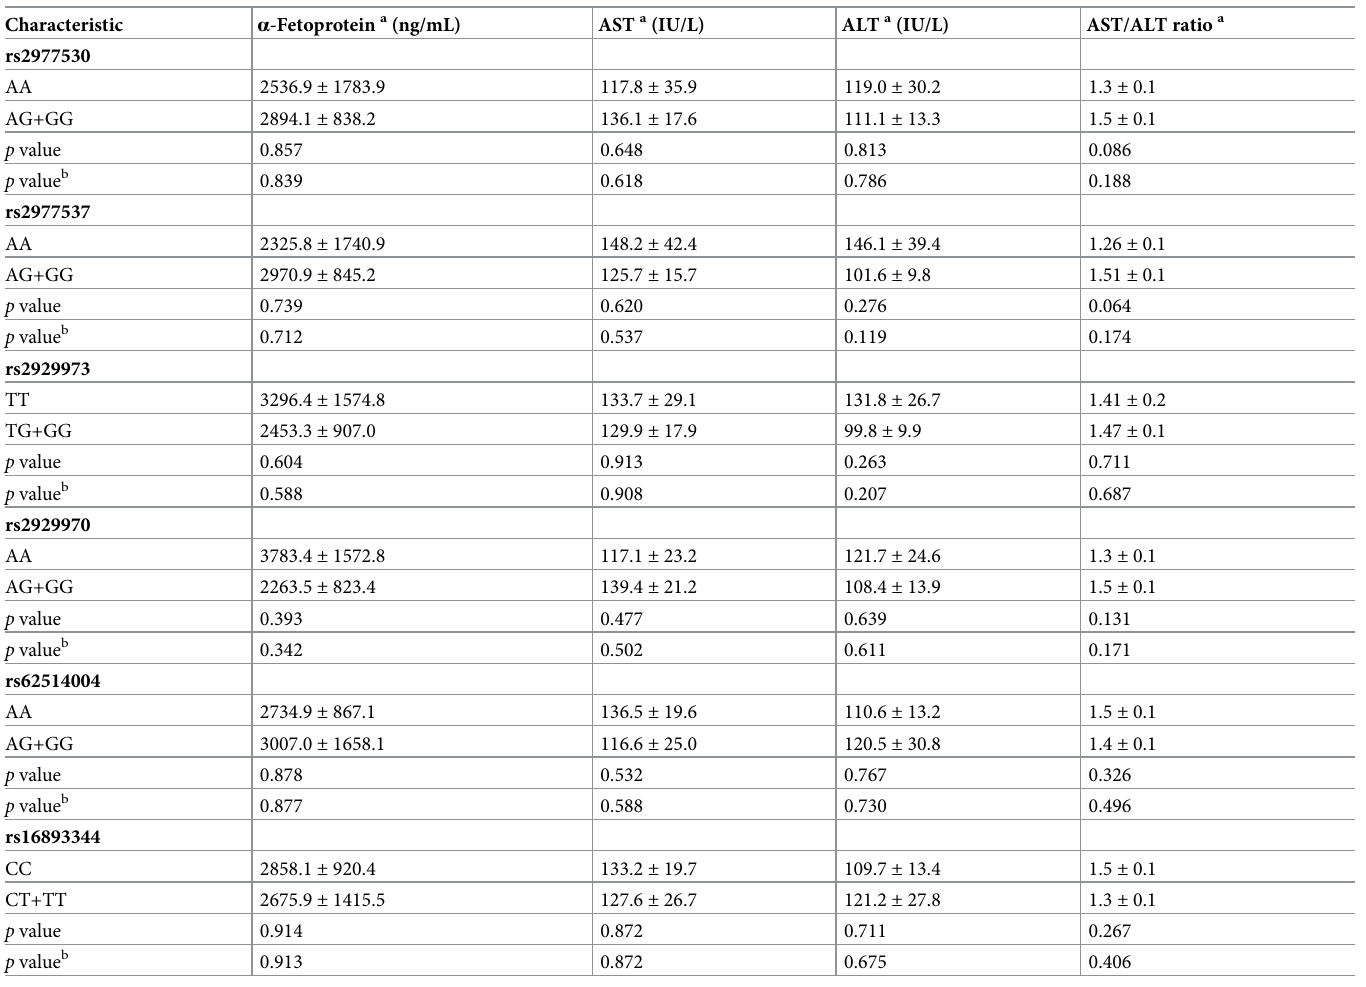
Mann-Whitney U test was used between two groups.